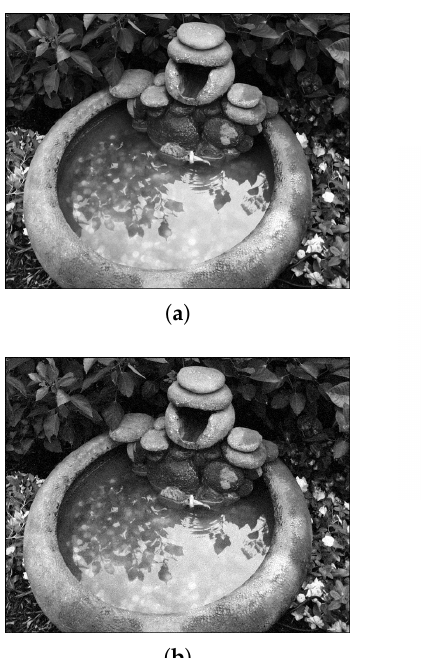
Figure 3. Comparison of image gradient statistics of the pristine noisy image and latent noisy image. The pristine noisy image has a standard deviation of 10, while the latent noisy image has a standard deviation of 5. ( a ) Latent distorted image, standard deviation of 5. ( b ) Pristine distorted image, standard deviation of 10. ( c ) Image gradient statistics along the